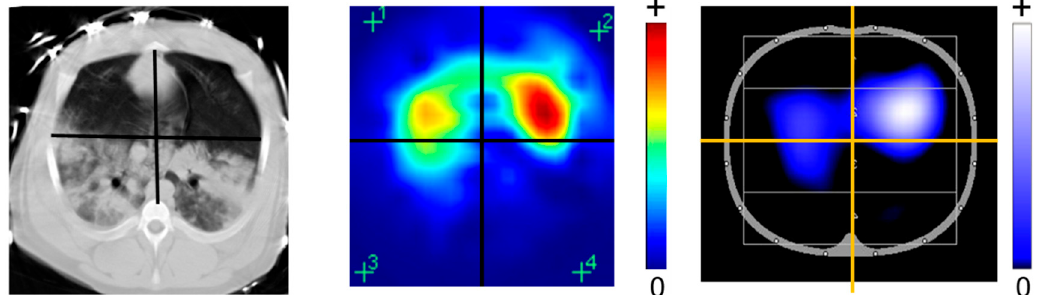
Figure 2. Different available color codings of EIT images in comparison to the CT scan. The rainbow-color scheme uses red for the highest relative impedance (e.g., during inspiration), green for a medium relative impedance, and blue for the lowest relative impedance (e.g., during expiration). A newer color scales use instead black for no impedance change), blue for an intermediate impedance change, and white for the strongest impedance change.